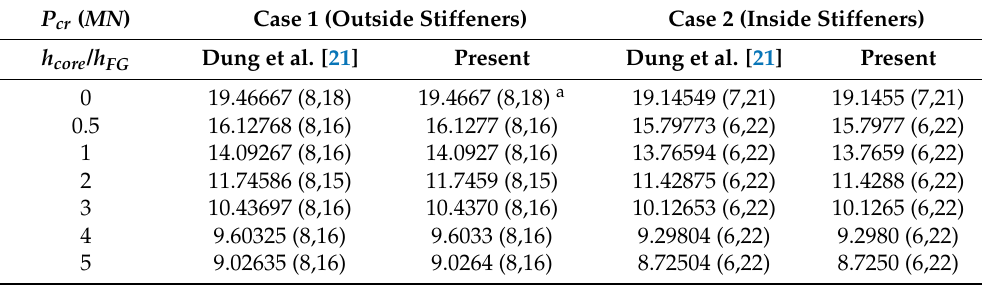
Table 3. Linear critical load of stiffened FG sandwich truncated conical shells.